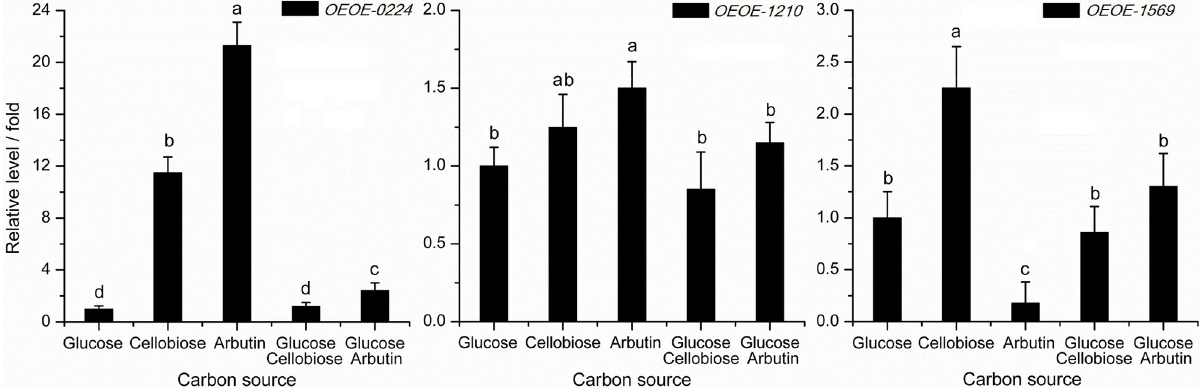
Fig 4. Expression levels of bgl gene in O . oeni SD-2a cultured with different carbon sources. Note: The sample cultured with glucose represented 1 × expression of target gene.